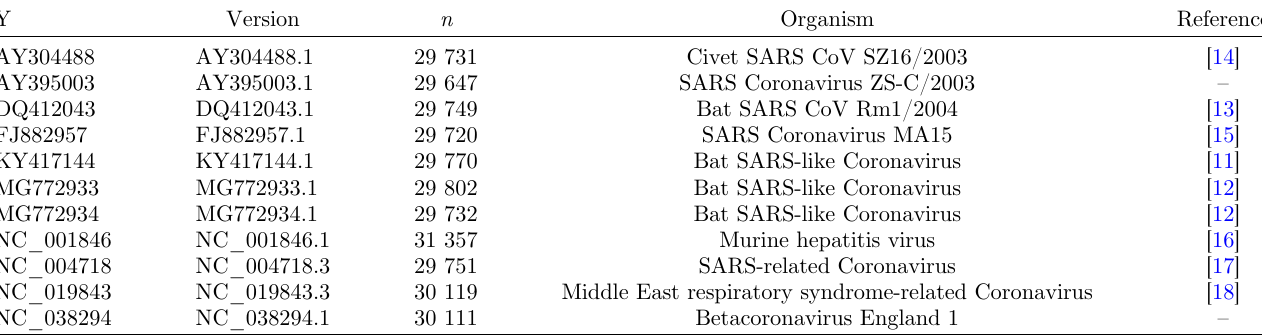
Table 9. Complete genome sequences coming from https://www.ncbi.nlm.nih.gov/nuccore/Y. For each sequence Y are informed, its Version , sample size n , Organism and Reference